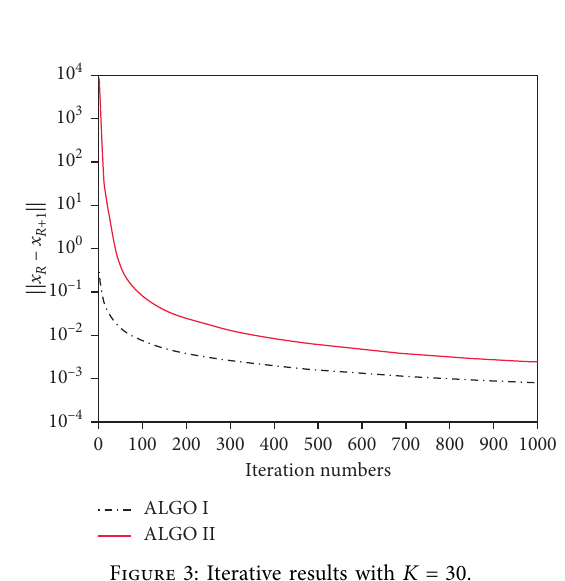
Figure 1: Iterative results with K � 50. Figure 2: Iterative results with K � 40.